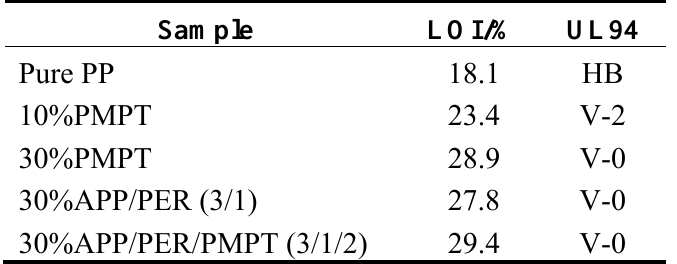
Table 1. Effect of PMPT and APP/PER/PMPT on the